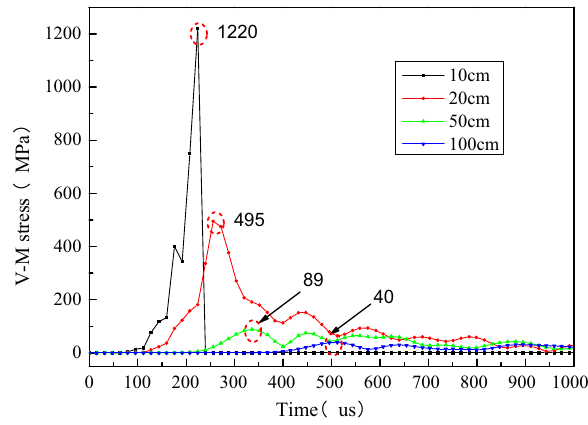
Fig. 7 Time-history curves for effective stress at different positions and distances from blasting